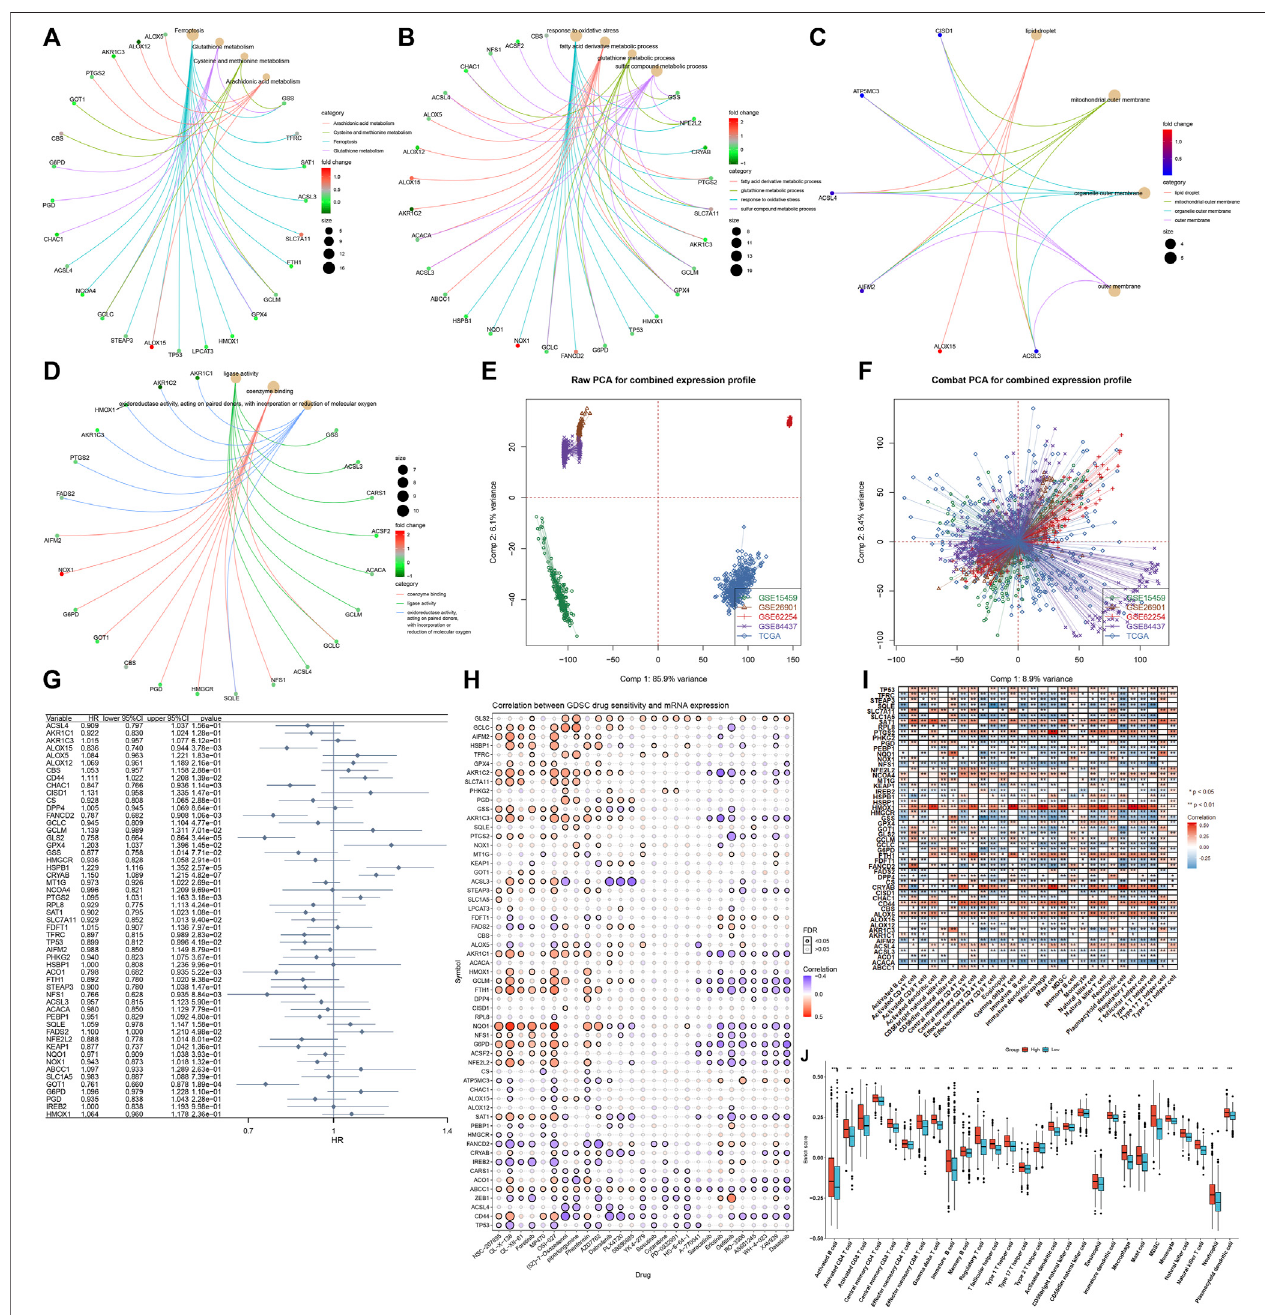
FIGURE2 | Biological function, prognostic implication, and immunecell in fi ltration correlation offerroptosis regulators inthe GCmeta-cohort. (A) KEGG pathways involved in ferroptosis regulators. (B – D) Biological processes, cellular components, and molecular functions enriched by ferroptosis regulators. (E) Integration of the mRNA expression data of fi ve GC datasets: TCGA-STAD, GSE84437, GSE62254, GSE26901, and GSE15459. (F) Removal of batch effects. (G) Forest plot showing the association between ferroptosis regulators and GC prognosis through univariate Cox regression models. (H) Spearman correlation analysis between ferroptosis regulators and drug sensitivity via the GDSC database. Red, positive correlation; blue, negative correlation. The size of the bubble was proportional to the correlationcoef fi cient. (I) Spearmancorrelationanalysisbetweenferroptosisregulatorsandtumor-in fi ltratingimmunecellsbyssGSEAmethod.Red,positivecorrelation; blue,negativecorrelation. (J) Comparisonsofenrichmentscoresoftumor-in fi ltratingimmunecellsinhighandlowHMOX1expressionGCsamples.* p < 0.05;** p < 0.01; and *** p < 0.001.